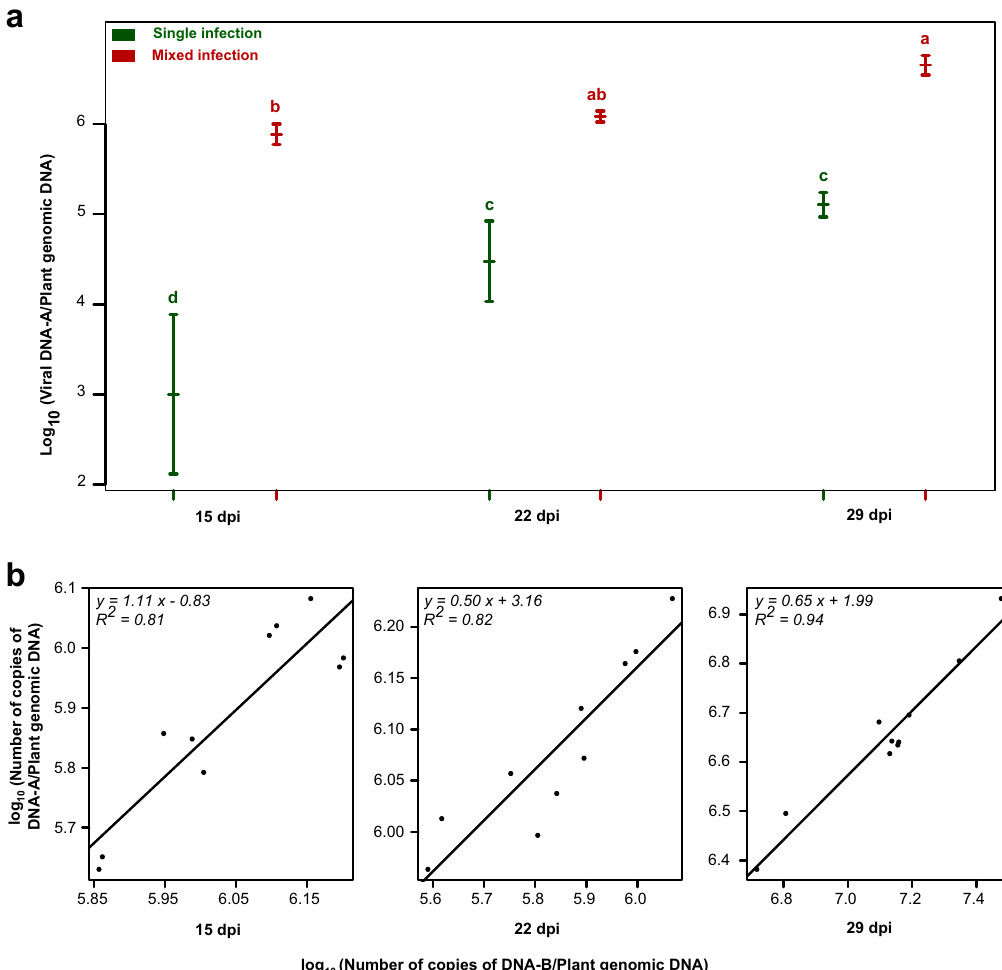
Figure 3. SYBR Green real-time PCR quantifications. ( a ) Average accumulation of PepYVMLV in single (DNA-A) or mixed (DNA-A and -B) infection of tomato plants ( Solanum lycopersicum ) at 15, 22 and 29 days post inoculation (dpi). ( b ) The bottom panels represent the linear correlation between PepYVMLV DNA-A and -B normalized loads. Vertical bars represent 95% confidence intervals. Identical letters on top of the bars indicate groups with non-significant differences in height.